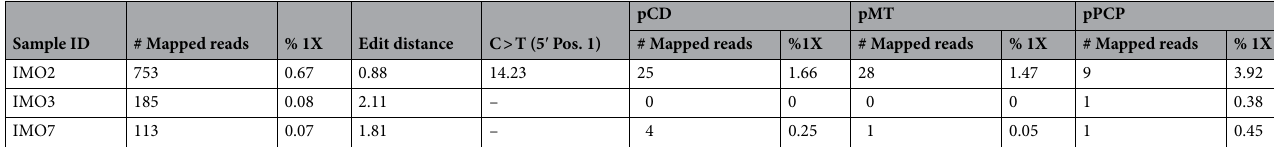
Table 3. Mapping statistics for alignments of shotgun datasets to the Y. pestis CO92 reference genome (-n 0.01; MQ > 30).